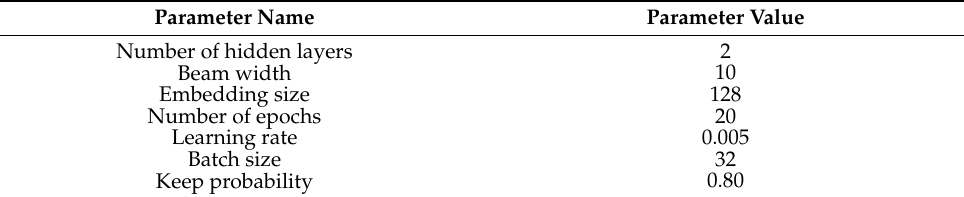
Table 8. Experiment parameters for number of units sensitivity analysis.